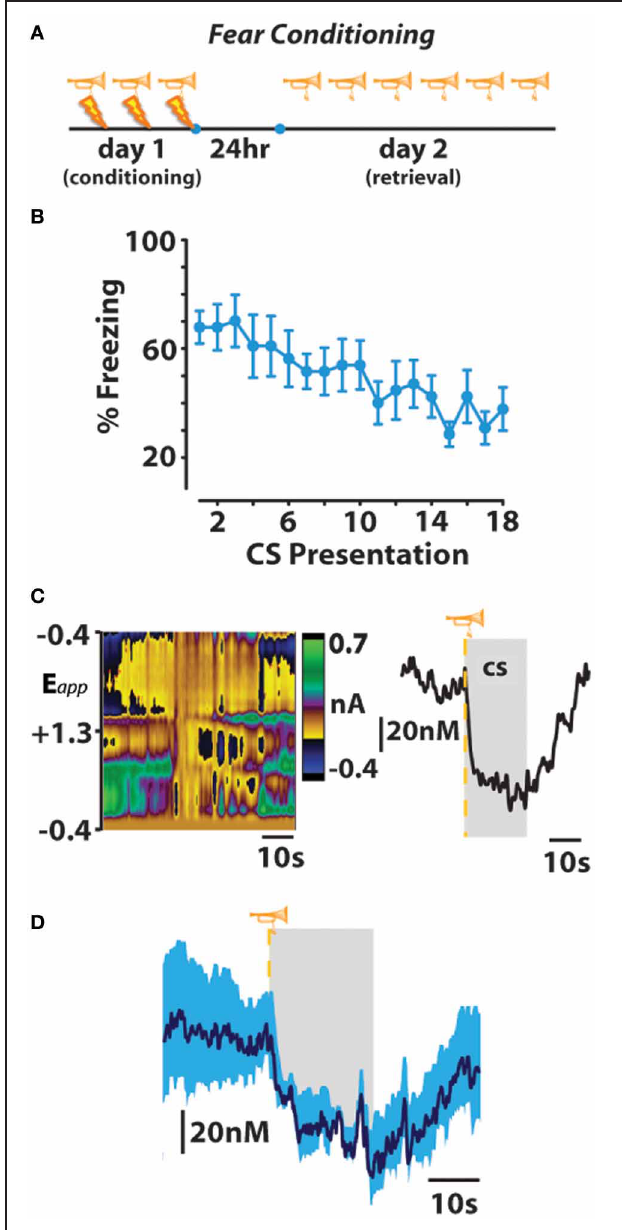
FIGURE 3 | Fear-conditioned stimuli freeze behavior and subsecond dopamine release events. (A,B) An otherwise neutral stimulus (trumpet) previously conditioned to inescapable footshock (lightning bolt) produces freezing behavior that extinguishes across repeated trials of conditioned stimulus (CS) presentation on fear-memory retrieval day. (C) Representative color plot (left) and corresponding dopamine concentration trace (right) show aCS-induced decrease indopamine release. Grayrepresents CSduration. (D) Mean ± SEM dopamine concentration trace during presentations of the fear-conditioned CS. Originally published in Oleson et al.